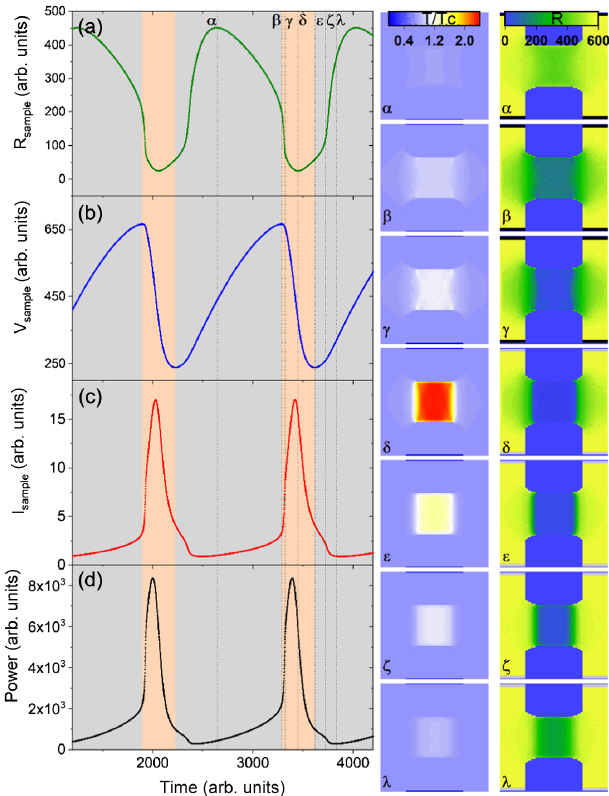
during the oscillations. Time dependence of (a) resistance, (b) voltage, (c) current, and (d) power simulated with a resistor network during the oscillation regime (see Supplemental Material [46] for details). The gray (orange) background corresponds to the charge (discharge) of the capacitance. Resistance and temper- ature maps “ α ” correspond to the device in the insulating state. Maps “ β ” correspond to the initiation of the filament when the device begins switching into a low-resistance state. Maps “ γ ” correspond to the device in the switched state when a high conductive filament is formed. The filament temperature is just above T c . Maps “ δ ” correspond to the device in the switched state at its minimum resistance and when the maximum current is reached, just after the maximum power is reached. The filament is wider than in maps γ , and the filament temperature increases. Maps “ ε ” correspond to the device in a switched state when the capacitor is completely discharged. The resistance starts to increase as the filament narrows. The temperature is above T c . Maps “ ζ ” correspond to the device in a switched state but in a cooler state. The temperature, although still above T c , is decreasing, and the filament continues to narrow. Maps “ λ ” correspond to the device just before the relaxed state. The device cools down to T c , and the filament